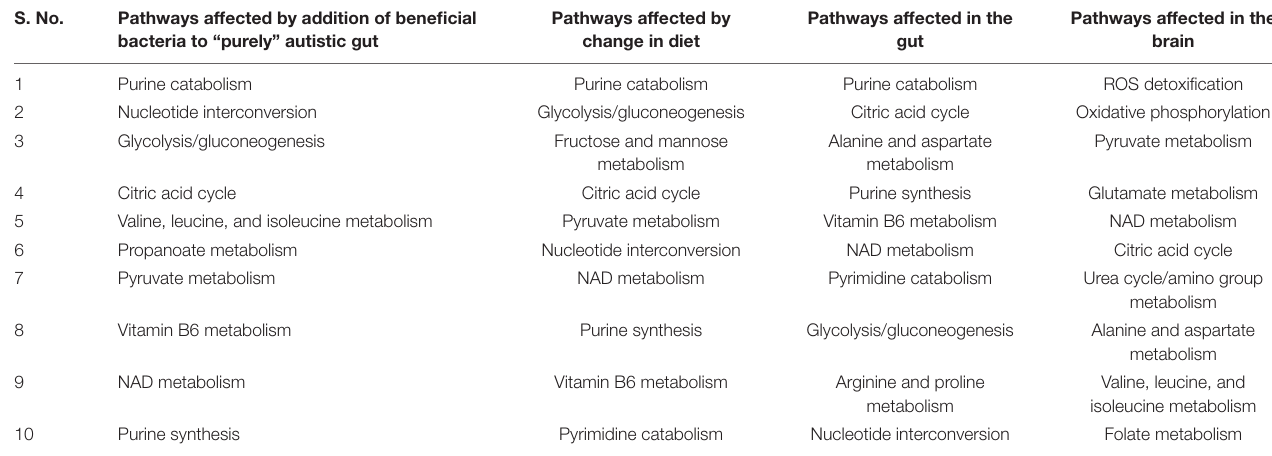
TABLE 4 | Top 10 gut metabolism pathways affected by harmful bacteria subsequent addition of beneficial bacteria, and change in diet, and effect of oxidative stress on the gut and brain. S.